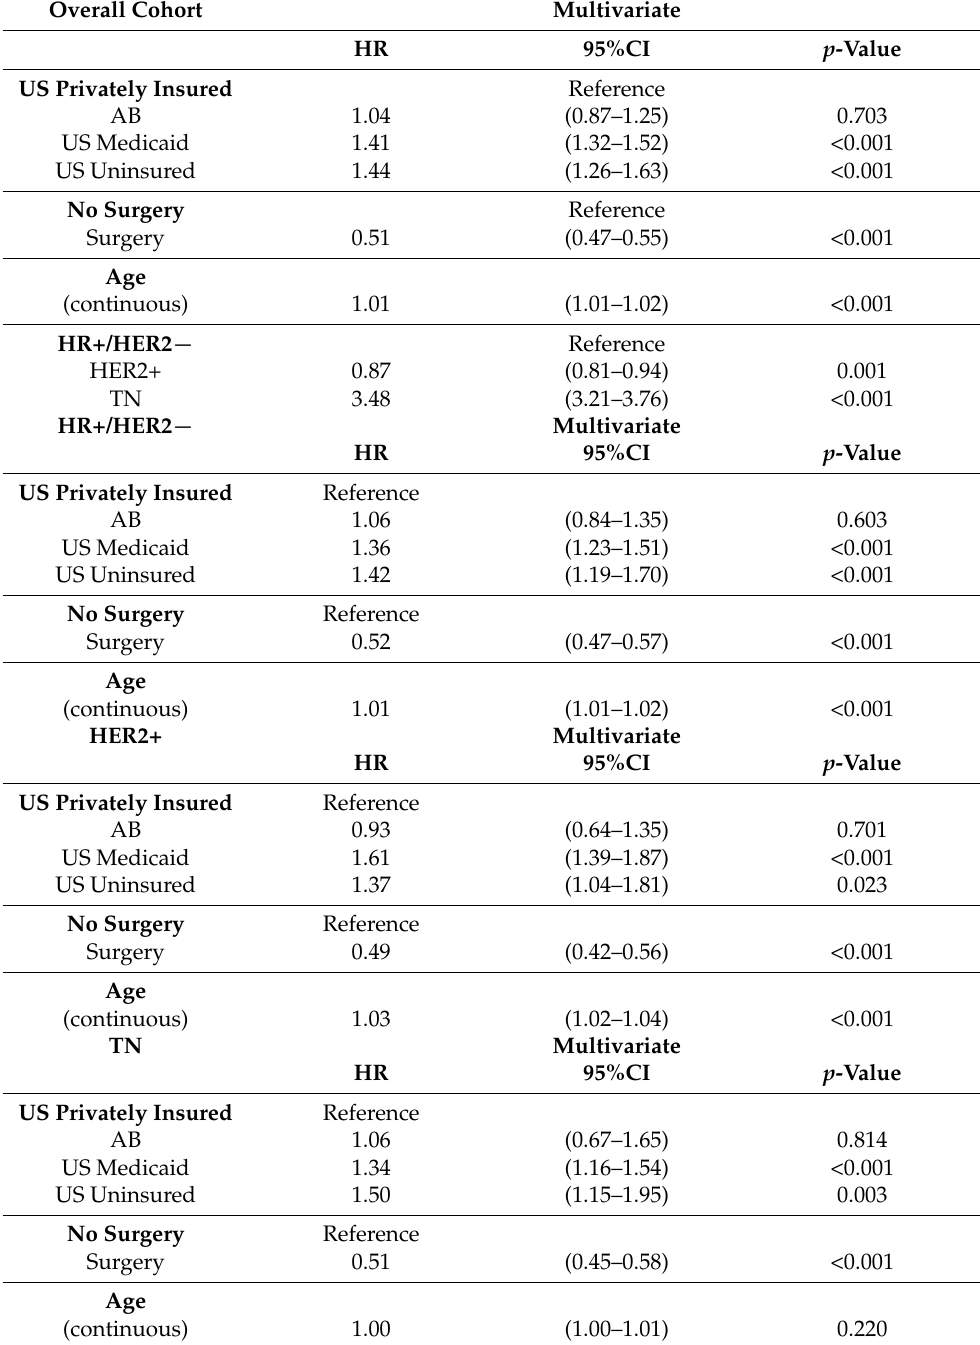
Table 2. Cox Multivariate Model by Insurance Status in Overall Cohort, HR+/HER2 − Patients, HER2+ Patients, and TN